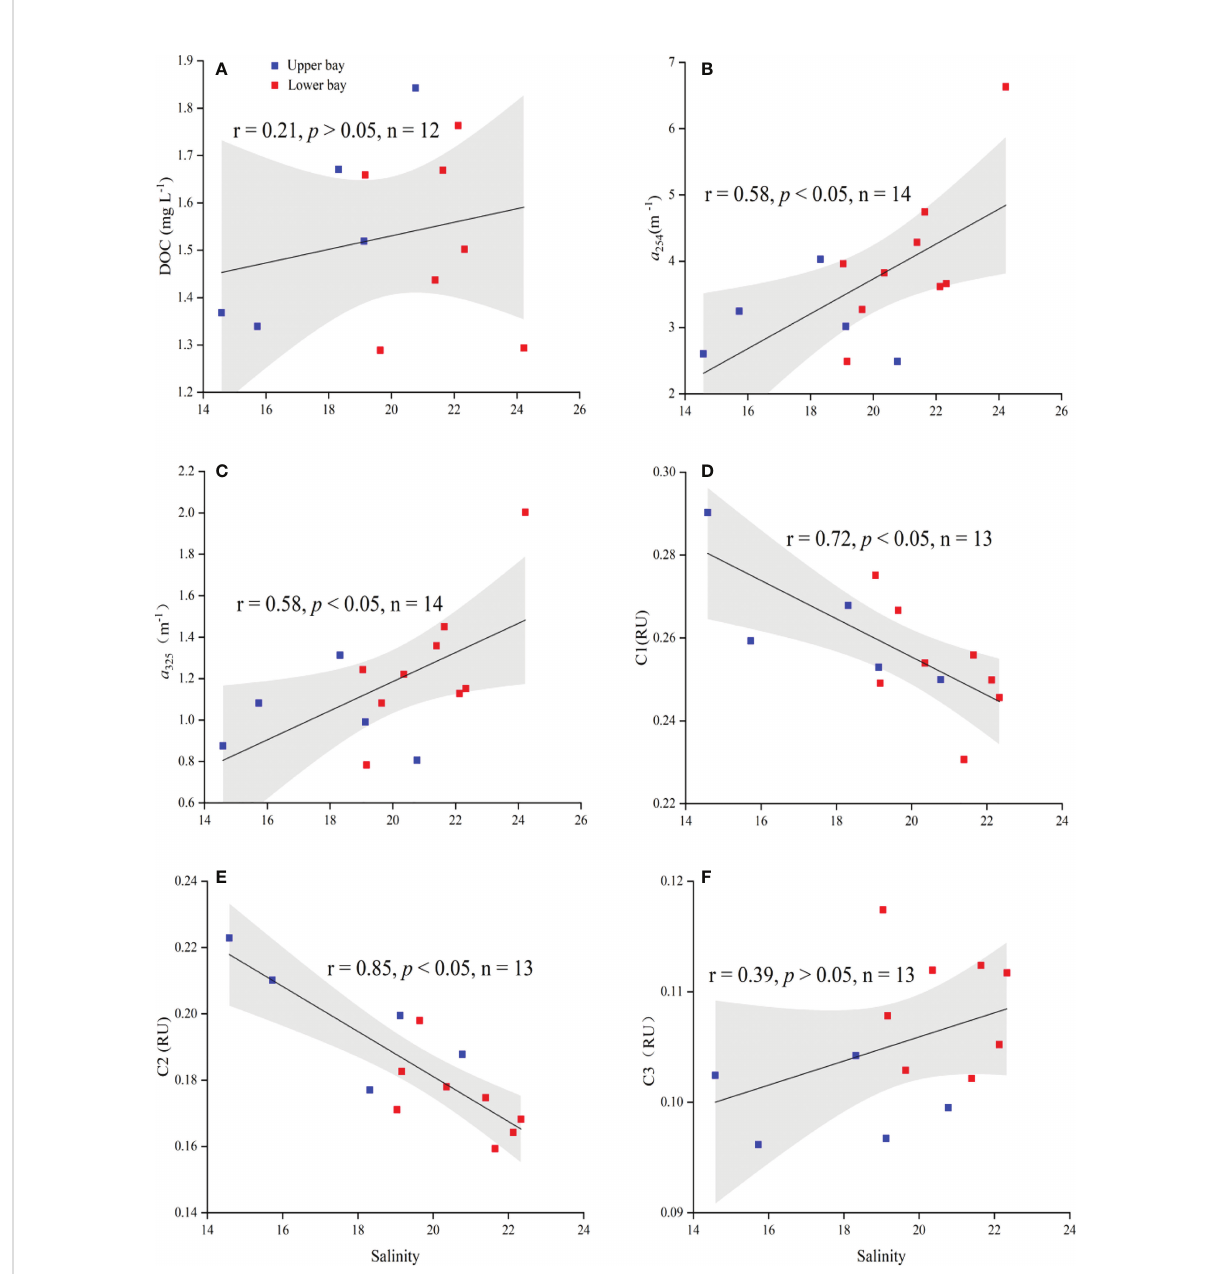
FIGURE 8 Relationships between (A) DOC and salinity, (B) a 254 and salinity, (C) a 325 and salinity, (D) C1 and salinity, (E) C2 and salinity, and (F) C3 and salinity in the water of Xi Bay. The black lines and gray shadows represent the linear fi t lines and 95% con fi dence bands. Because the DOC values in stations W8 and W10 and the FDOM (C1, C2, and C3) fl uorescence intensity in station W14 had no dates, these points were excluded from the